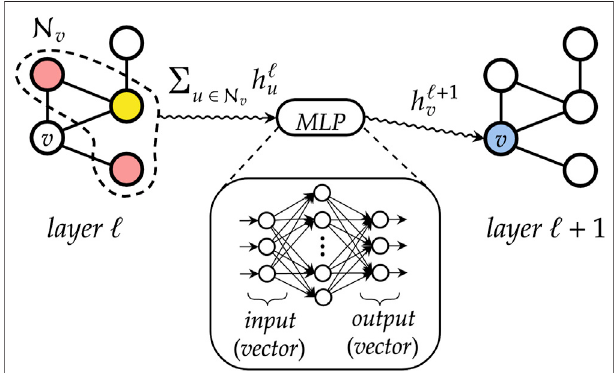
FIGURE 7 | A simpli fi ed representation of how a graph convolutional layer works. First, neighboring states of each vertex v are aggregated by means of a permutation-invariant function, to abstract from the ordering of the nodes and to deal with variable-sized graphs. Then, the resulting vector is fed into a multi-layer perceptron that outputs the new state for node v